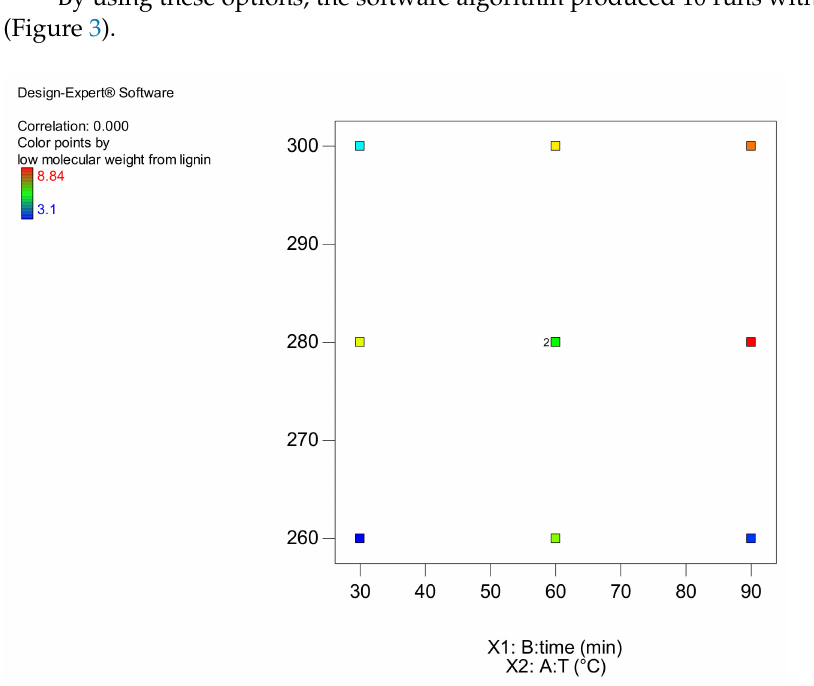
Figure 3. Matrix of the experimental